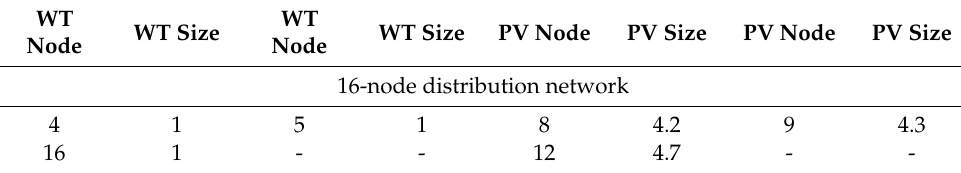
Table 7. WT and PV DGs sizes in MW at each node using